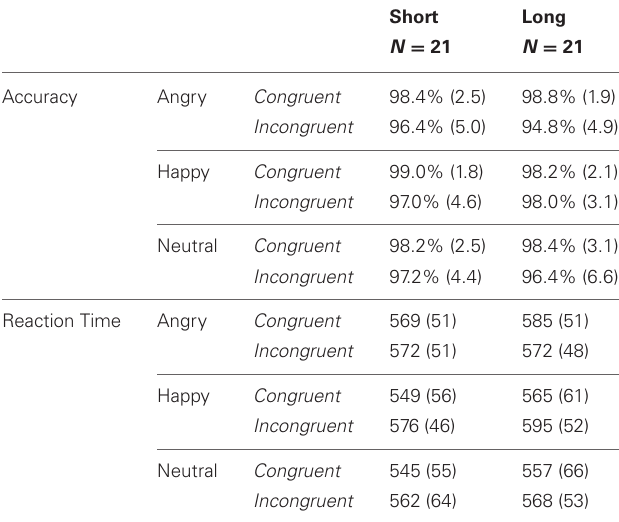
Table 2 | Mean accuracy (SD in parenthesis) and reaction time (in ms; SD in parentheses) for congruent and incongruent trials by emotional valence condition in short and long genotype